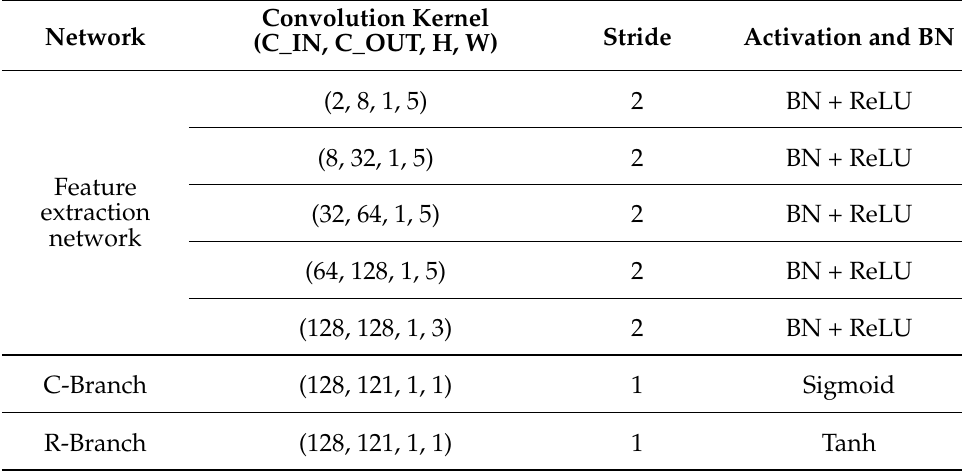
Table 1. Parameters of the proposed